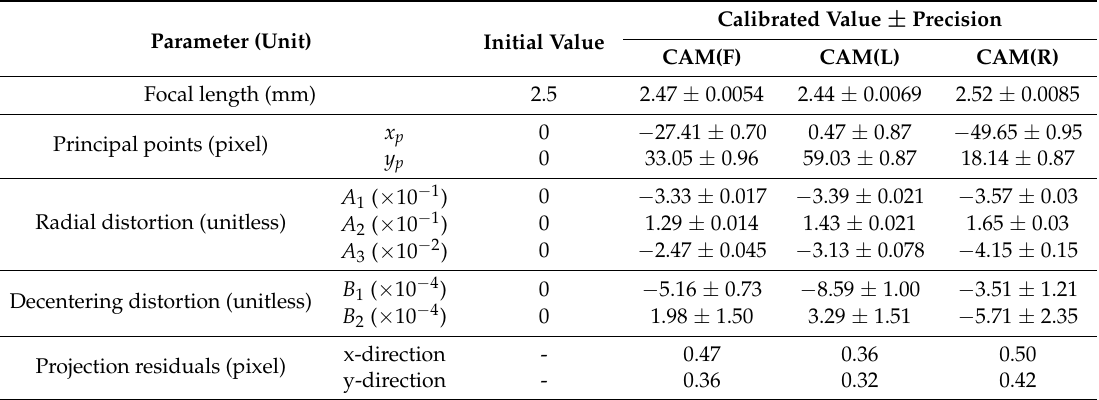
Table 5. Camera calibration results (precision: 1 σ ).